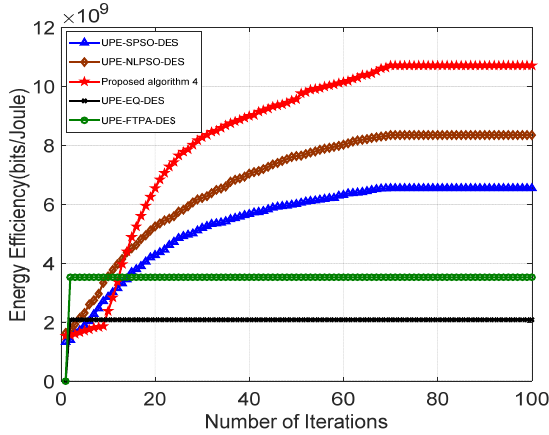
Figure 7. Convergence performance of joint algorithm.